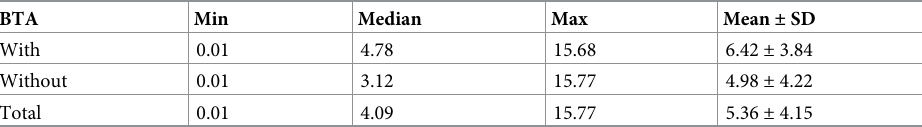
Table 2. Years of follow-up. BTA Min Median